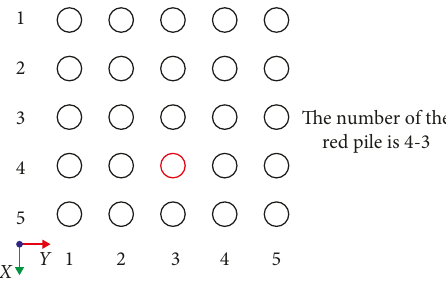
Figure 8: Layout of